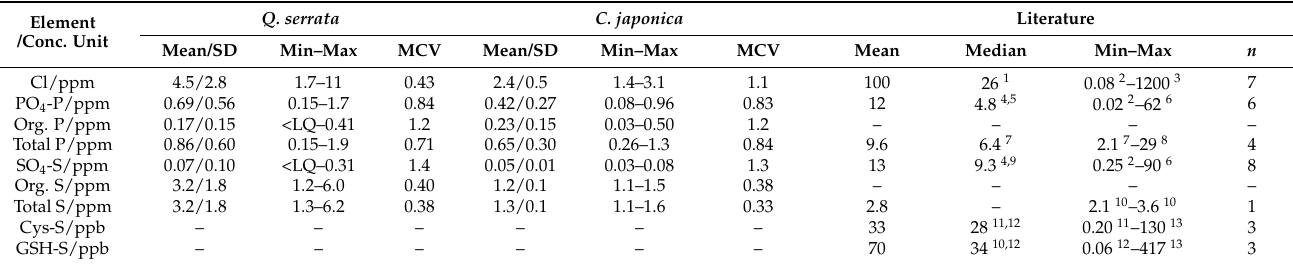
Table 3. Concentrations of nonmetallic elements in the xylem sap obtained in Experiment 1 and those reported in the literature.